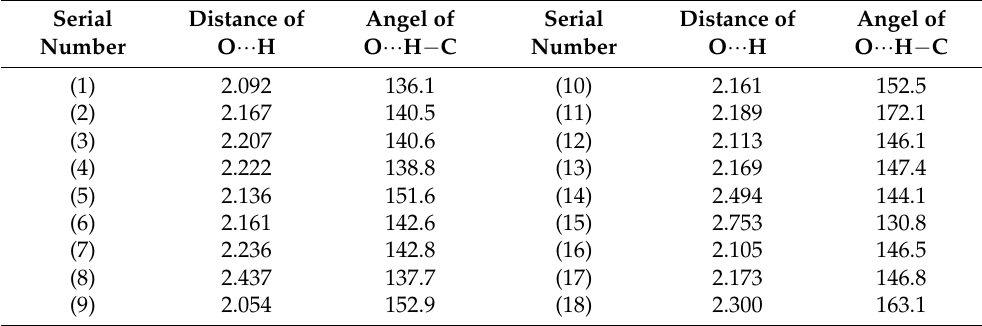
Figure 5. Optimized geometries of the transition state TS3/4 in HCOO − rotation. The atom colors are the same as above. The distances are in Å, and the O − C − O bond angles are in degree ( ◦ ). The red dotted lines represent hydrogen bonding, and the number indicates the distance of O ··· H (Å). The detailed parameters of these hydrogen bonds are listed in Table 5. Table 5. Parameters of hydrogen bonds in the optimized geometries of the transition state TS3/4 in HCOO −